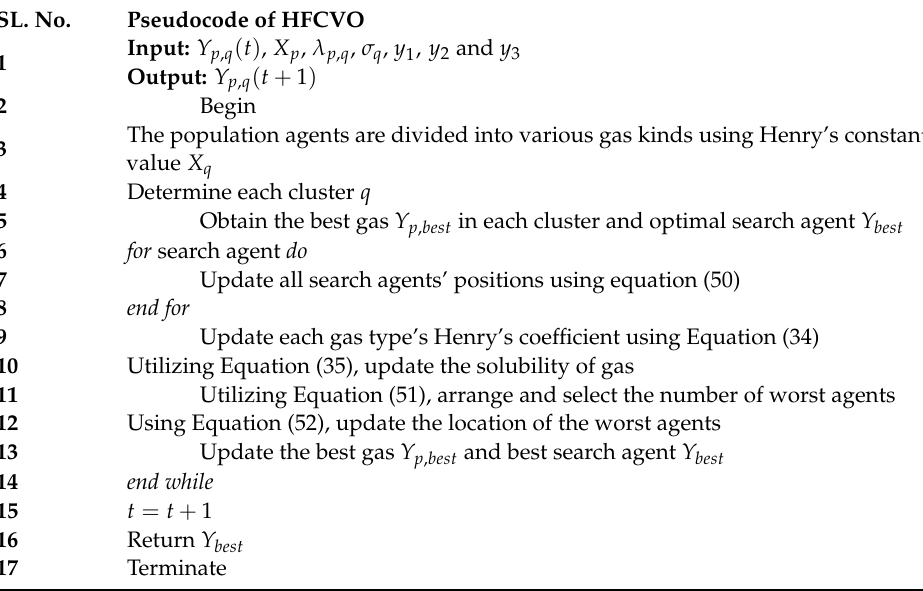
Algorithm 2. Pseudocode of proposed